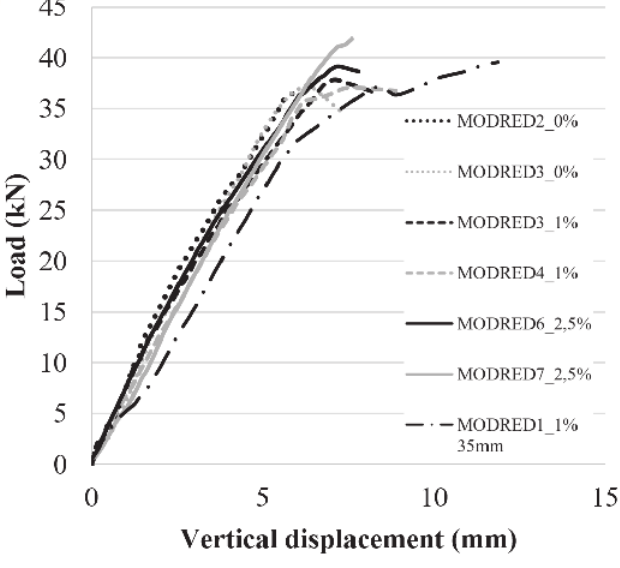
Load x vertical displacement curves of the hybrid beams (Author)